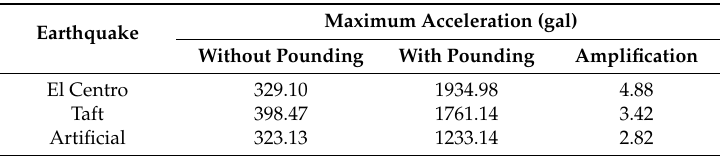
Figure 17. Structural acceleration under different earthquakes (model B). ( a ) El Centro earthquake; ( b ) Taft earthquake; ( c ) Artificial excitation. ( b ) Taft earthquake; ( c ) Artificial excitation. Table 4. Maximum acceleration values for model A. Table 4. Maximum acceleration values for model A.